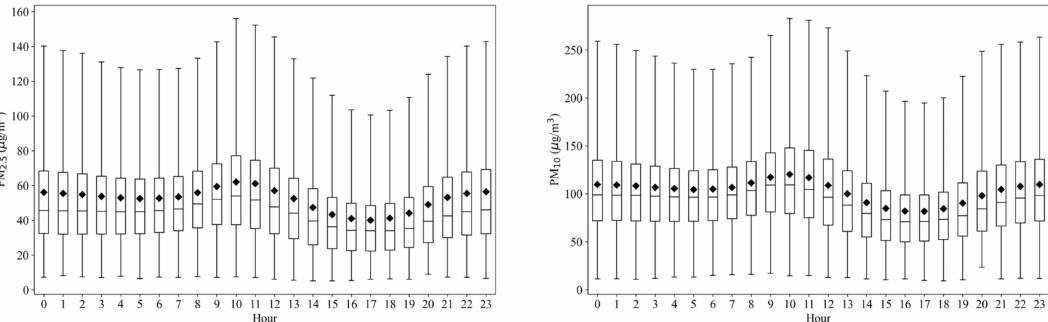
Figure 3. Diurnal variation of PM 2.5 and PM 10 concentrations in the study area during